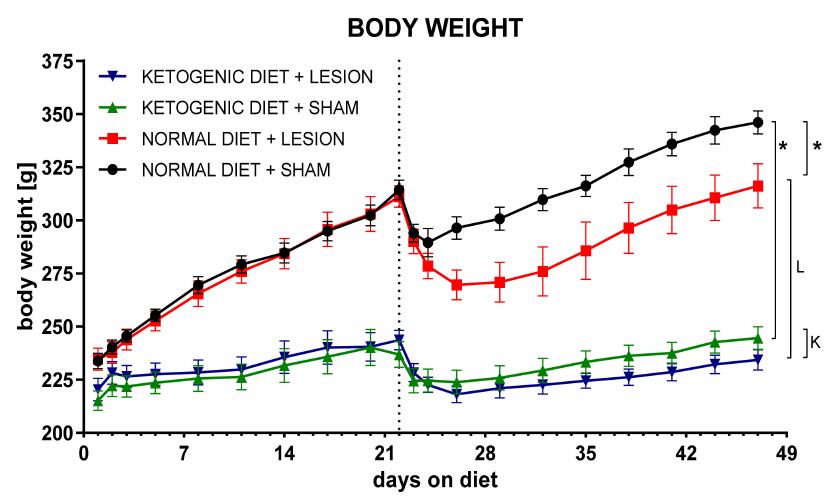
Figure 1. Animal body weight analysis. Data presented as change in body mass, showed as mean ± SEM representative for the group tested for the longest period. Analysis was performed for 3 weeks before and 4 weeks after brain surgery. Dashed line marks the day of operation. p value ≤ 0.05 was set as significance threshold and marked as * vs. normal diet + sham, L vs. normal diet + 6-OHDA lesion, K vs. ketogenic diet + sham. Repeated measure ANOVA with LSD post hoc test for analysis in time and 3-way ANOVA with LSD post hoc test for analysis of total values were performed. Number of animals in groups was: for NS n = 16; for NL n = 14; for KS n = 17; for KL n = 16.